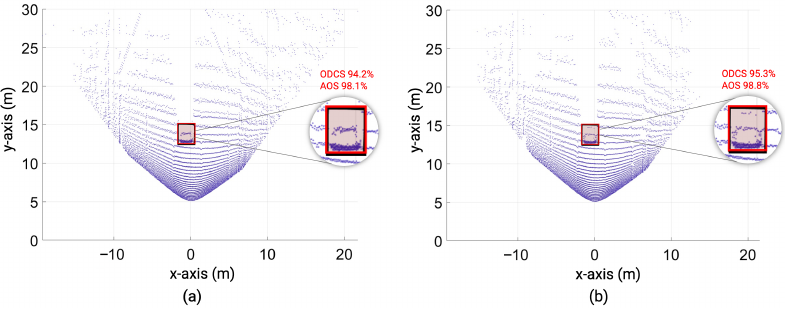
Figure 29. ( a ) Real point cloud data: Black and red cuboids represent the ground-truth 3D orienta- tion of the object and the 3D orientation of the object estimated by the object detection algorithm, respectively. ( b ) Synthetic point cloud data: Black and red cuboids represent the ground-truth 3D ori- entation of the object and the 3D orientation of the object estimated by the object detection algorithm,